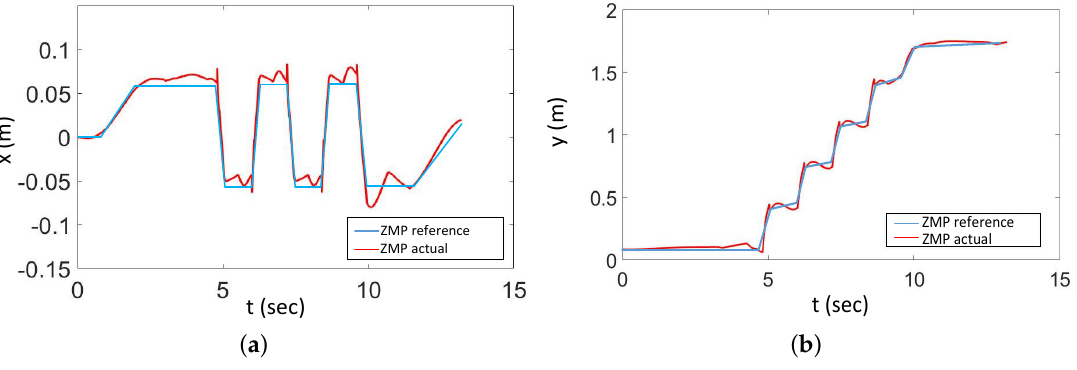
Figure 19. ZMP reference vs. actual with previous LIP ( a ): Lateral ZMP, ( b ): Longitudinal